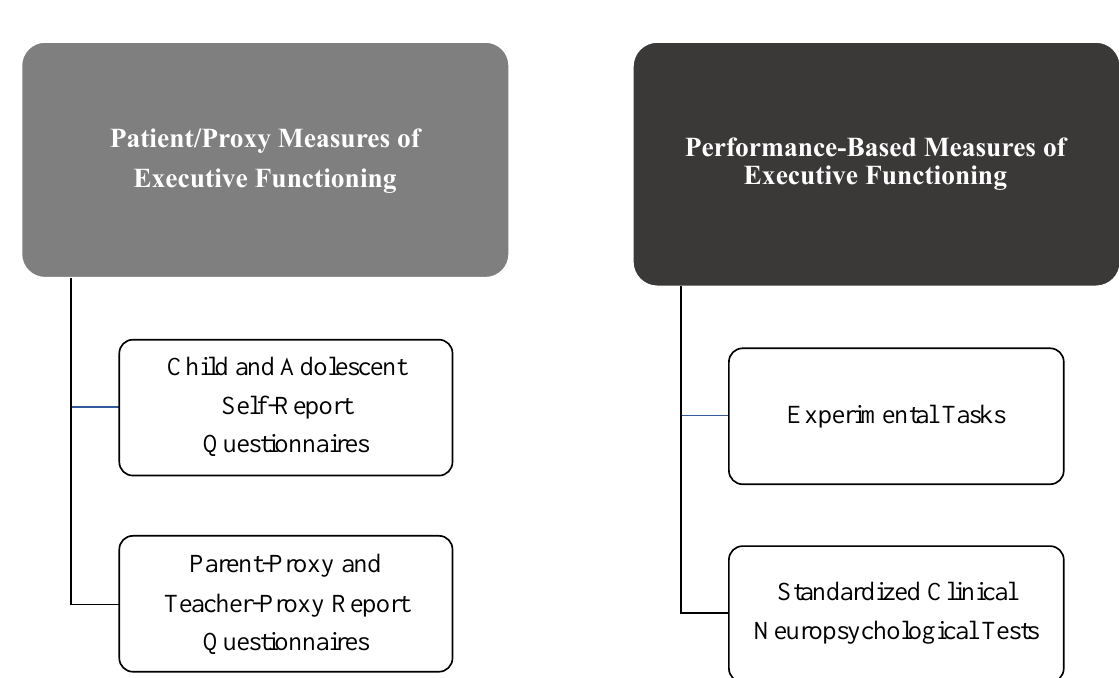
Figure 2. Methods of measuring executive functioning in youth with chronic pain.